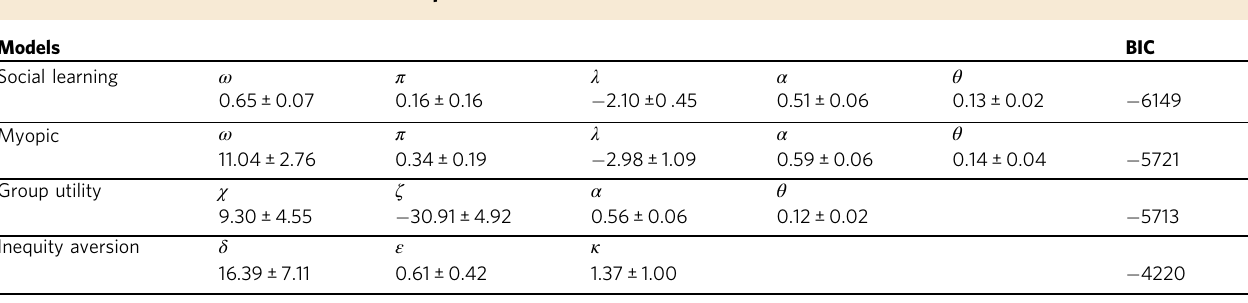
Table 1 Parameter estimates and model comparison of behavior. Models BIC